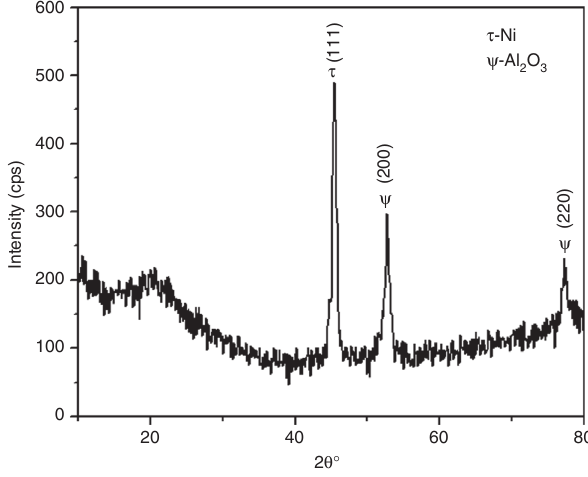
O composites of AISI 304 stainless 2 3